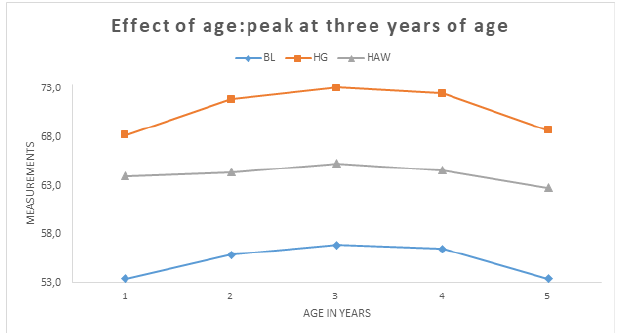
Figure 3. Effect of age on body length (BL), heart girth (HG), and height at withers